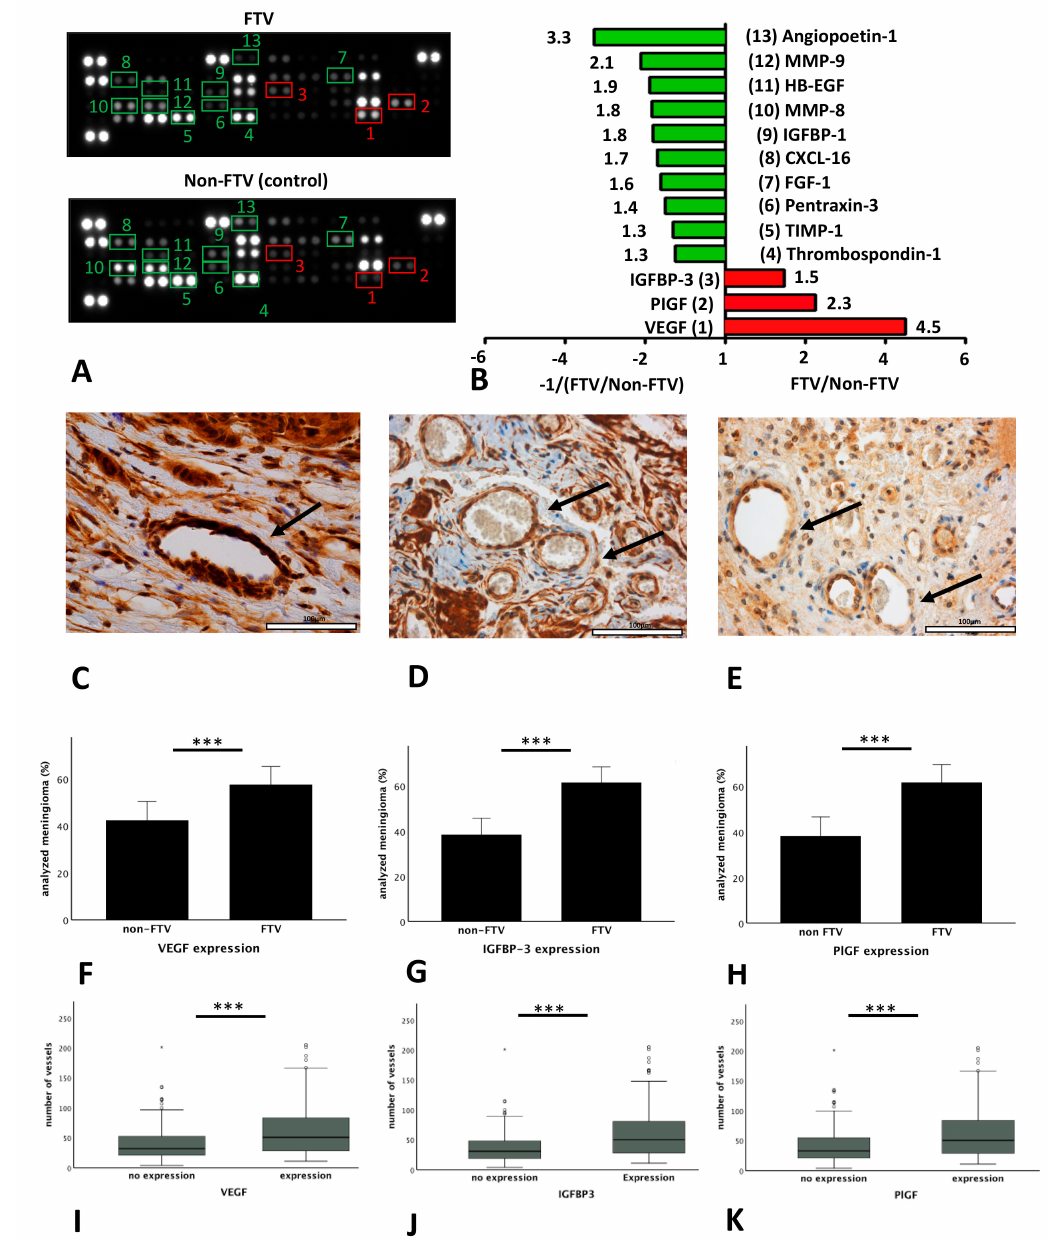
Figure 3. Expression of VEGF, IGFBP-3, and PlGF in meningioma vessels: Measurement of the optical density of meningioma samples with FTV and disruption of the arachnoid layer (FTV group, n = 8; A top) and without FTV and disruption of the arachnoid layer (non-FTV control group, n = 7; A bottom). The FTV group displays the distinct expression of various angiogenesis related proteins as compared to the non-FTV group ( B ). The immunohistochemical data confirm the results of the angiogenesis proteome profiler arrays and demonstrated significant di ff erences in the endothelial expression (arrows) of vascular endothelial growth factor (VEGF; C ), insulin-like growth factor-binding protein-3 (IGFBP-3; D ), and placental growth factor (PlGF; E ) evaluated using semi-quantitative analyses ( F – H ). Furthermore, the expression of VEGF, IGFBP-3, and PlGF correlated significantly with vessel density in the meningiomas ( I – K ). Original magnification: 400 × . Error bars: 95%CI. *** p <